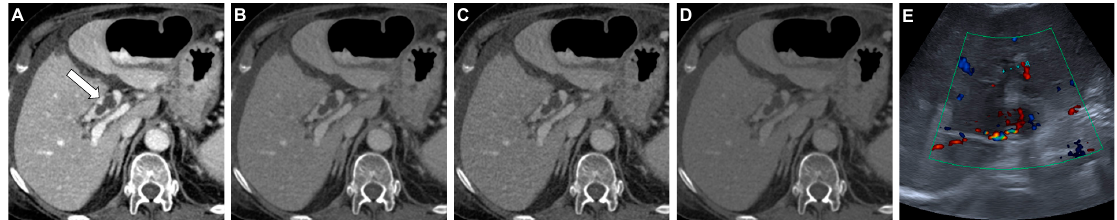
Figure 3. Axial DECT images of a 90-year-old woman with liver cirrhosis and portal vein thrombosis ( arrow ). Noise-optimized virtual monoenergetic imaging (VMI+) series at 40 keV ( A ) show higher vascular attenuation of the portal vein and a better delineation of the thrombus compared to 60 keV VMI+ ( B ), 60 keV VMI ( C ), and standard linearly blended M_0.6 images ( D ). On color duplex ultrasonography, some color signals are visible within the boundaries of the thrombus ( E ). Table 3. Qualitative image analysis. The image parameters image noise, image contrast, image quality, and suitability were compared between linearly blended M_0.6, standard virtual monoenergetic imaging (VMI) at 60 keV, and noise-optimized VMI+ series at 40 keV and 60 keV levels.